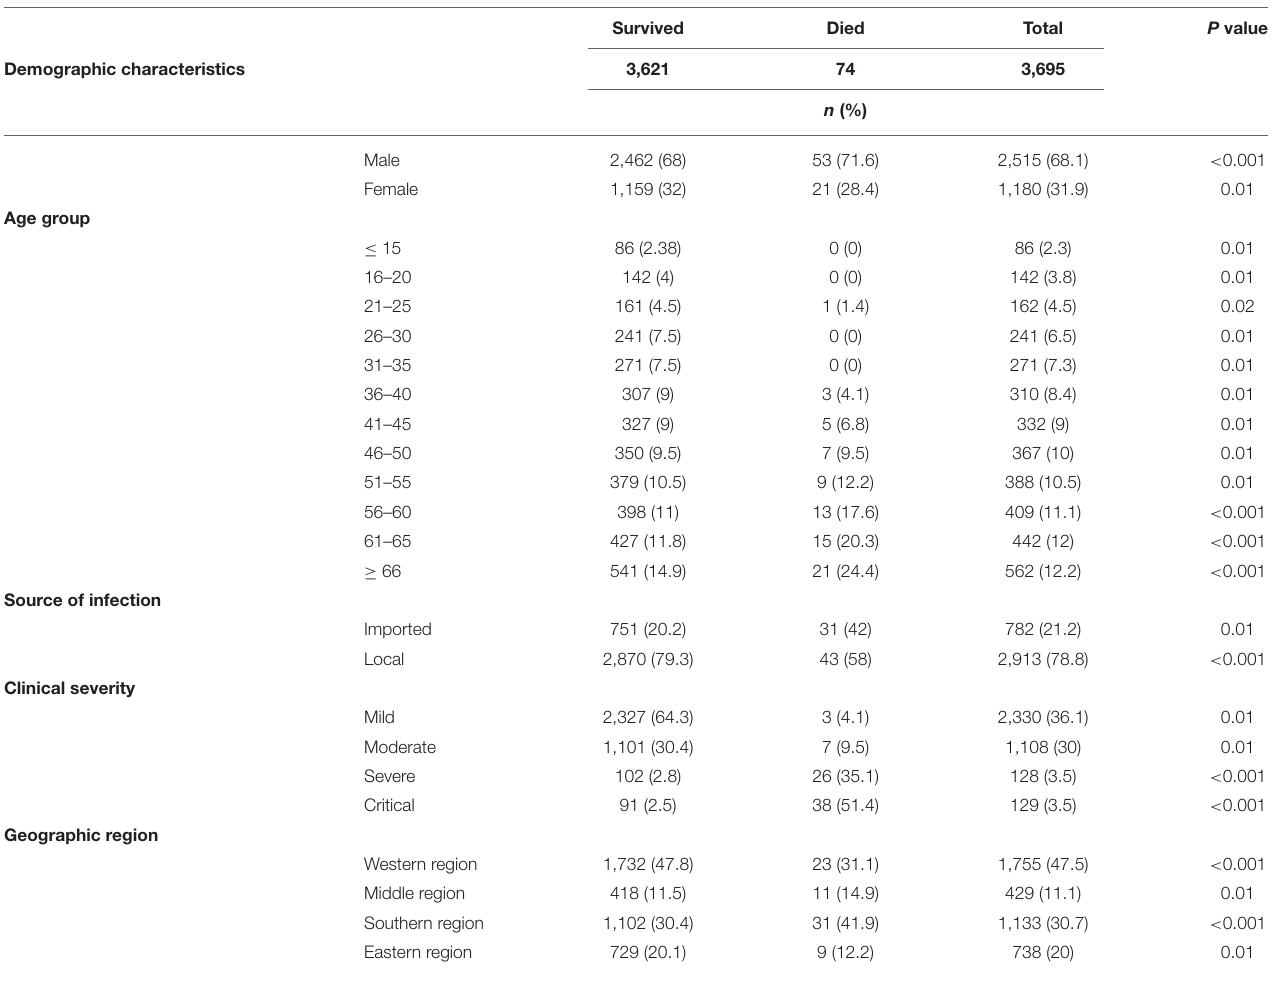
TABLE 1 | Epidemiologic and demographic characteristics of 3,695 confirmed cases of COVID-19 infection in